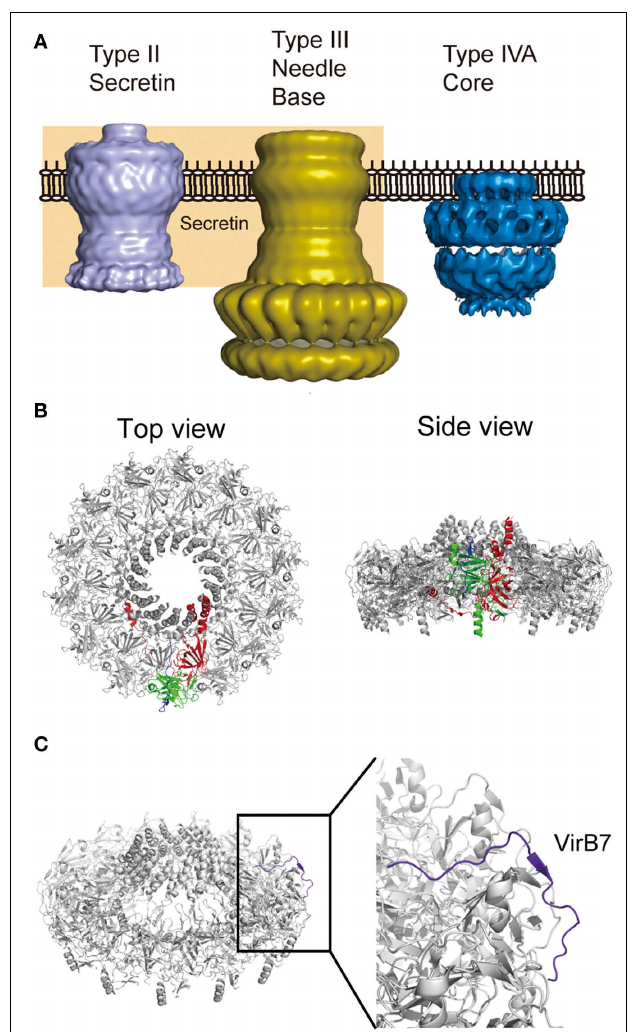
FIGURE 4 | Core complex of pKM101T4ASS. (A) Comparison of electron micrographic structures of Vibrio cholera secretin GspD (type II secretin; EMDB accession EMD-1763; Reichow et al., 2010), type III injectisome isolated from (cid:2) invJ Salmonella typhimurium (type III needle base; EMD-1224; Marlovits et al., 2006), andT4ASS core complex of pKM101 conjugal plasmid (type IVA core; EMD-5031; Fronzes et al., 2009). (B) Top and side views of pKM101 outer membrane complex (PDB accession 3JQO; Chandran et al., 2009). One of each protomer in the complex is shown in color:VirB7 (blue),VirB9 (green), andVirB10 (red). (C) VirB7 takes an extended form in the complex. Figures are generated using PyMol (Schrodinger, 2010) and resources deposited to indicated